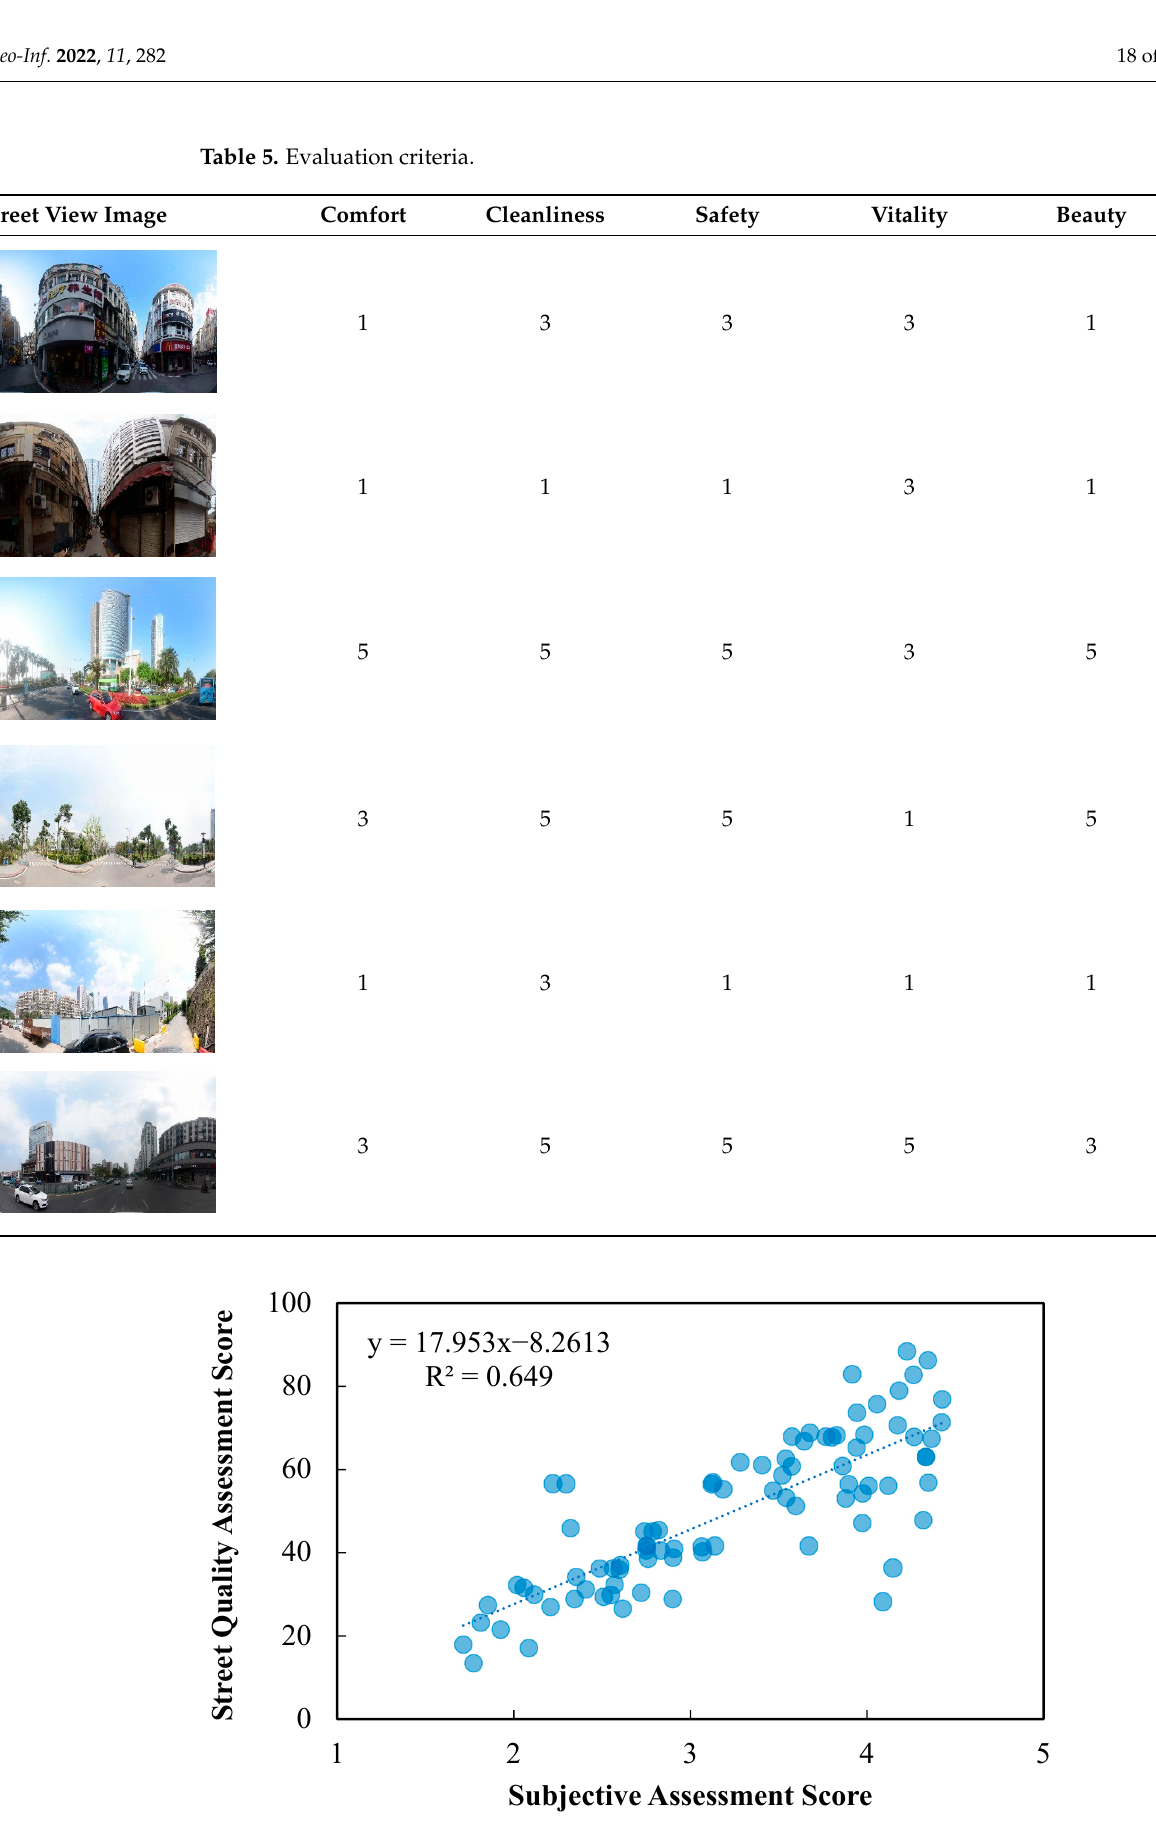
Figure 15. Relationship between street quality assessment score and subjective assessment score.